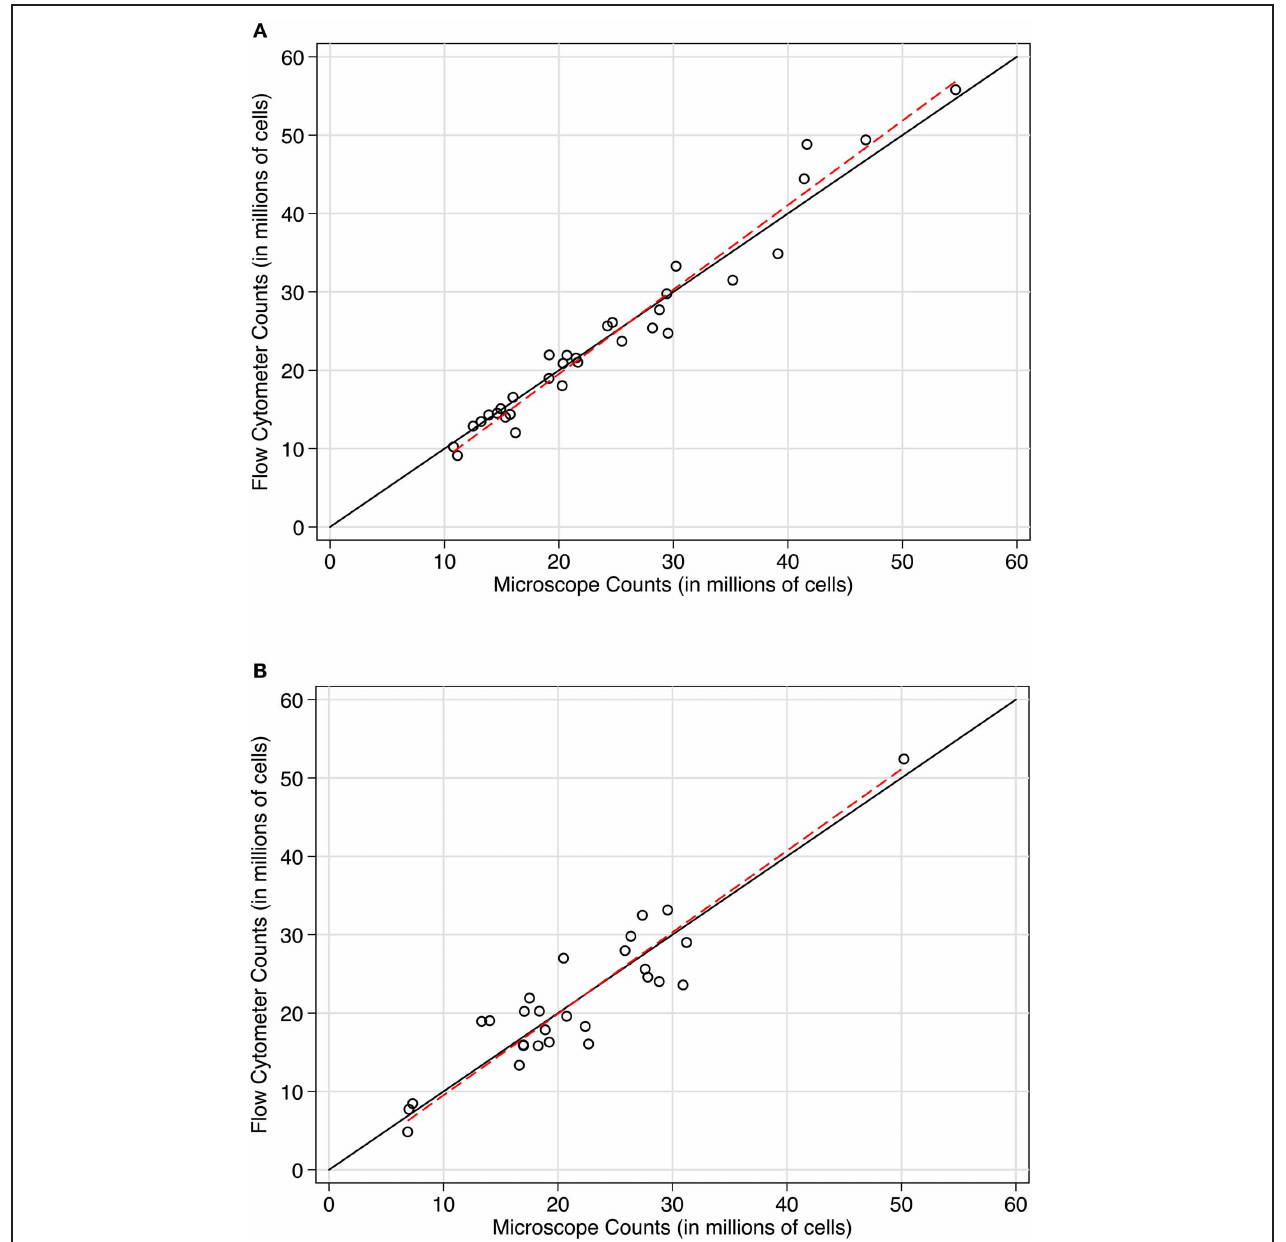
FIGURE 4 | Concordance scatterplots of cell density estimates in (A) case 11-31 and (B) case 10-04. Points are plotted with flow fractionator counts along the Y-axis and manual microscope counts on the X-axis. The black line is the line of perfect concordance, Y = X in each plot. The red line